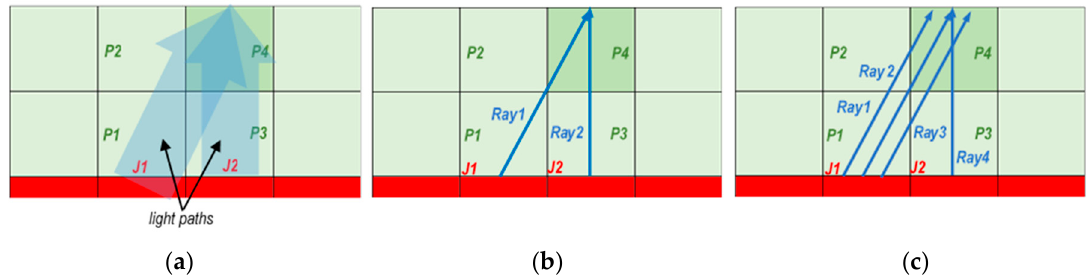
Figure 15. Illustrations for modeling the propagation of the blue light; ( a ) 3D paths of the blue light; ( b ) Single 1D rays of the blue light; ( c ) Multiple 1D rays of the blue light.